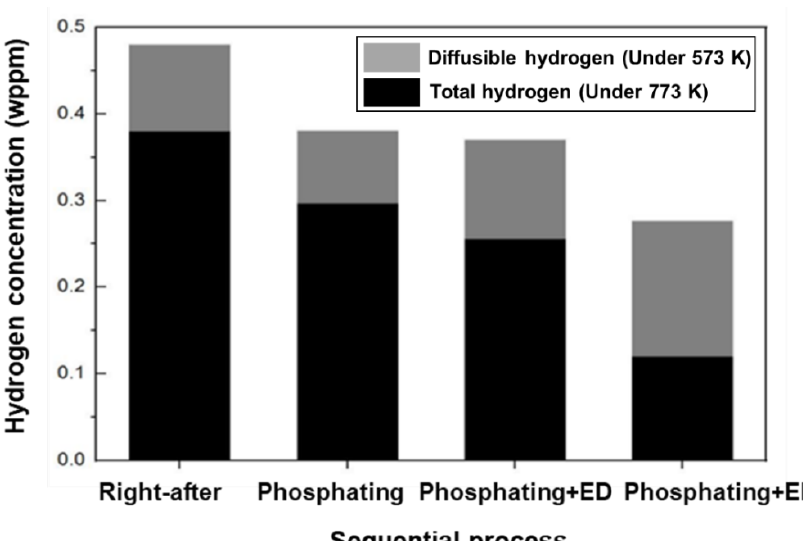
Figure 9. The diffusible hydrogen content after automotive sequential process on the 300 s specimen of 1.8 GPa hot-stamped boron